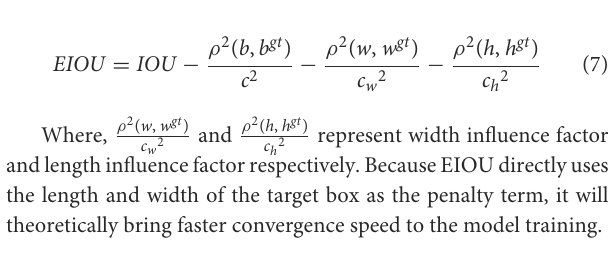
model training converge